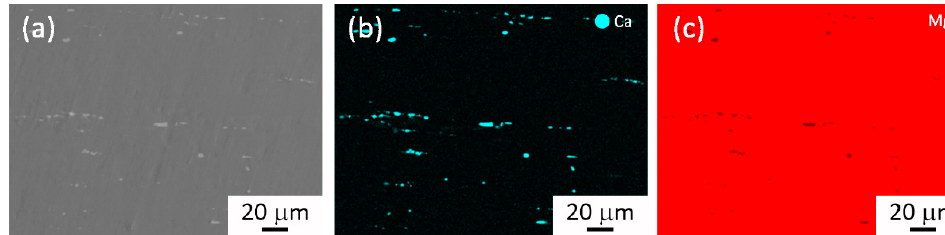
Figure 4. SEM observation of ZX10 alloy extruded at 400 ◦ C: ( a ) SEM image, corresponding elemental maps of Ca ( b ) and Mg ( c ).